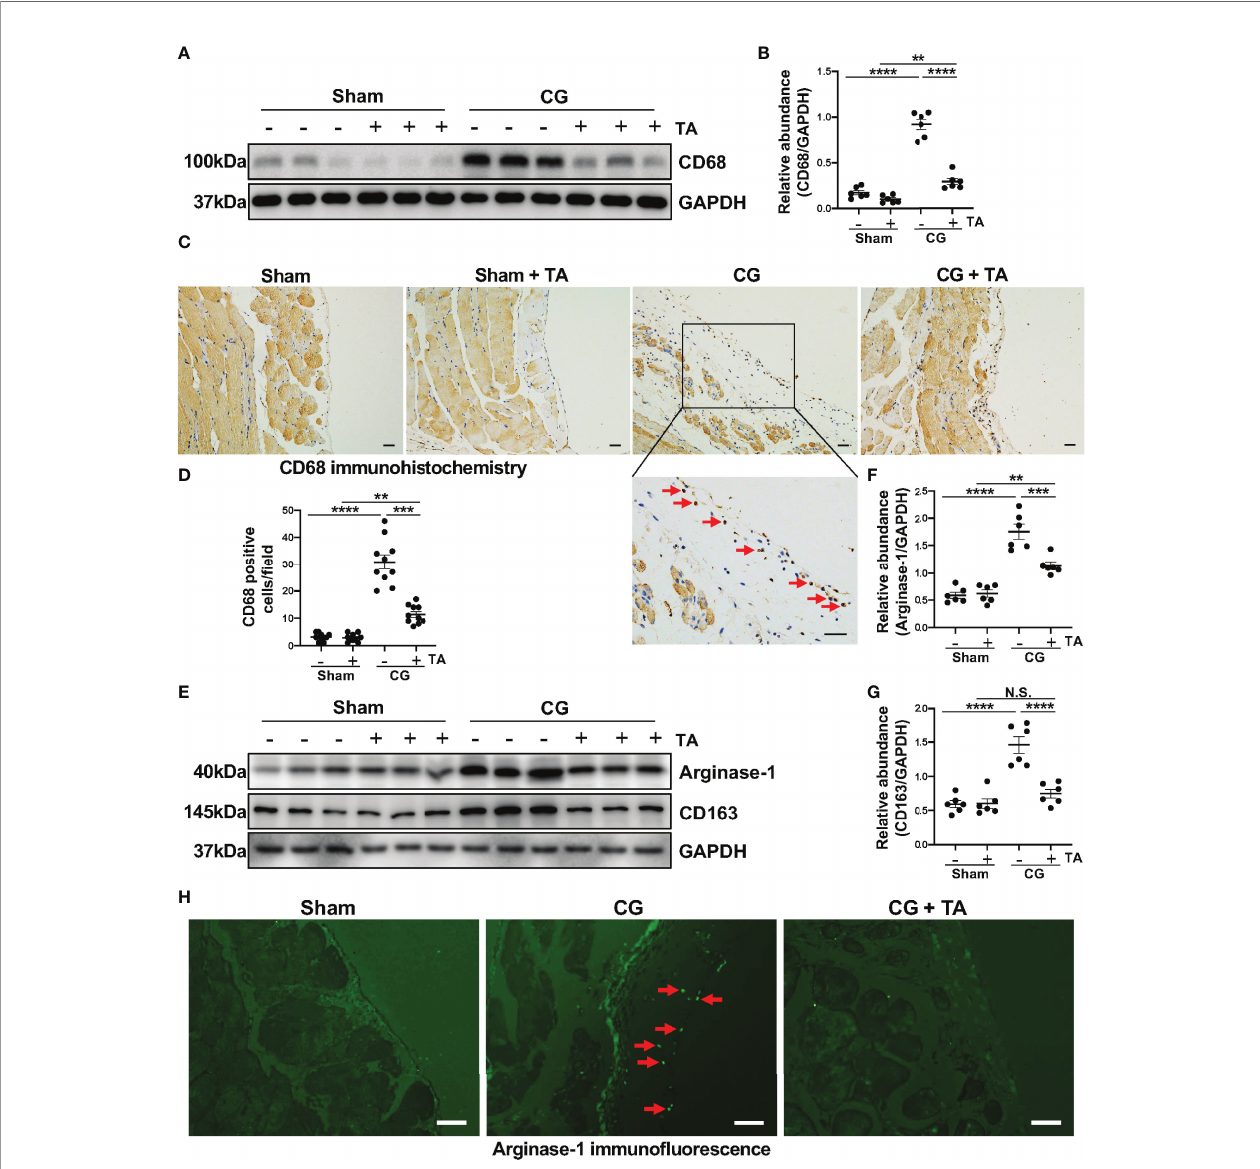
FIGURE 3 | Inhibition of HDAC6 prevents macrophage in fi ltration and alternatively activated macrophages (M2) polarization in CG-induced mouse model. (A) Western blot analysis showed the levels of CD68 and GAPDH in peritoneum from different groups of mice. (B) Expression levels of CD68 in different groups were quanti fi ed by densitometry and normalized with GAPDH. (C) Representative micrographs of immunohistochemical staining of CD68 on peritoneum from different groups of mice. Red arrows represent CD68 positive cells. (D) Quantization count of CD68-positive cells. (E) Western blot analysis showed the levels of Arginase-1, CD163, and GAPDH in peritoneum from different groups of mice. Expression levels of (F) Arginase-1 and (G) CD163 in different groups were quanti fi ed by densitometry and normalized with GAPDH. (H) Representative micrographs of immuno fl uorescence staining of Arginase-1 in peritoneum from different groups of mice. Red arrows represent Arginase-1 positive cells. Data were expressed as means ± SEM. **P<0.01, ***P<0.001, ****P<0.0001. All scale bars = 20 m m. NS: P ≥